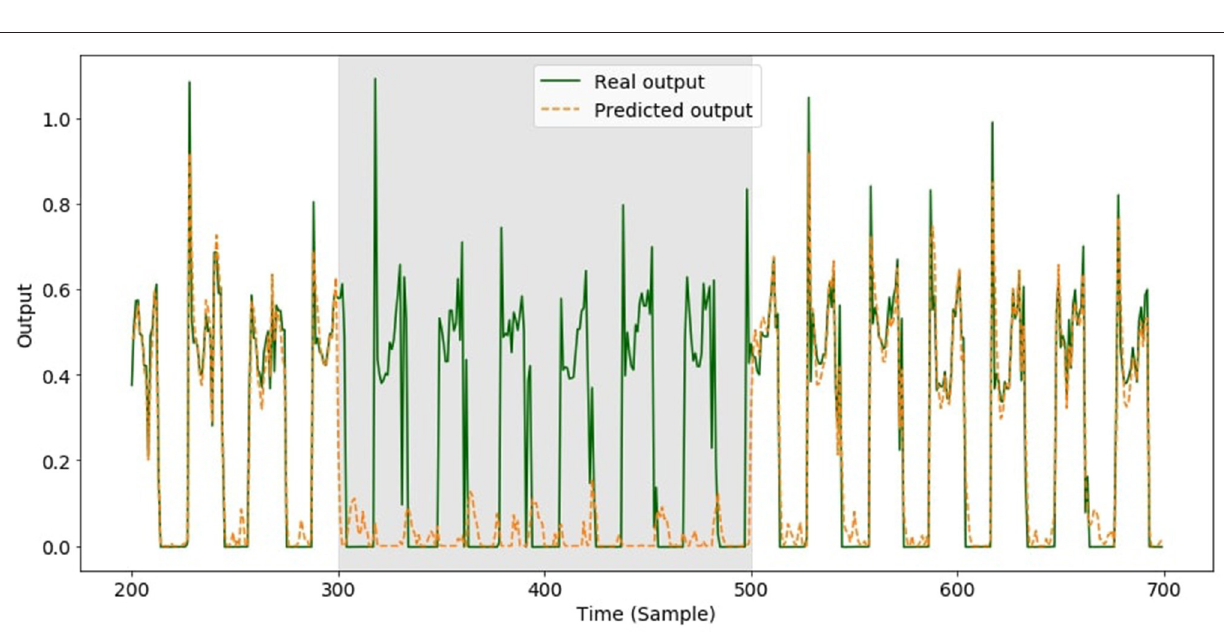
is required only for steering or attitude controlling